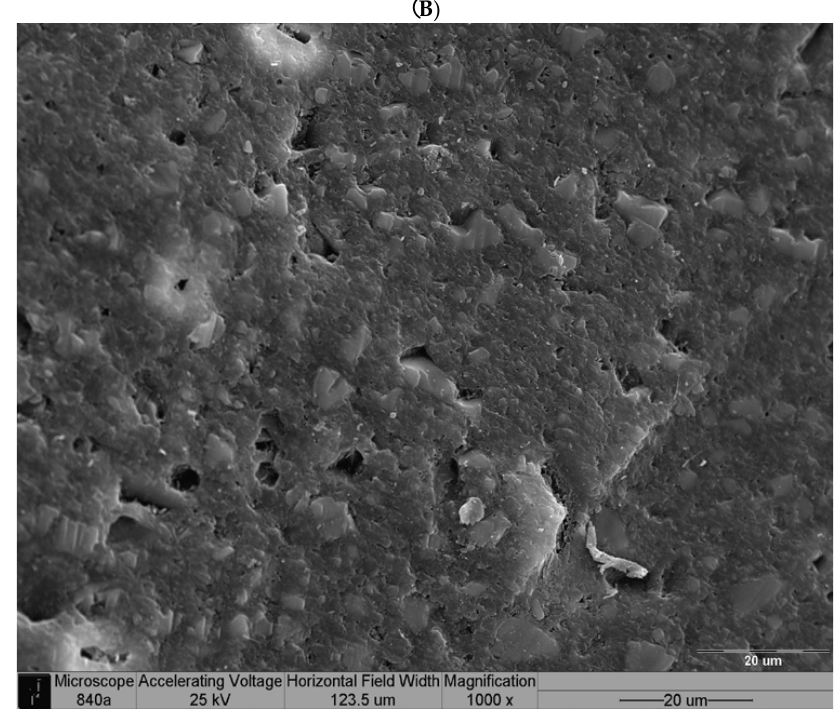
Figure 3. Scanning electron microscopy (SEM) micrograph of the dentin surface after pretreatment with desensitizing paste containing 8% arginine and calcium carbonate and incubation for 2 weeks: ( A ) The longitudinal striations of the bur (200×); ( B ) Most of the dentin tubules were occluded, but several were still patent (1000×).